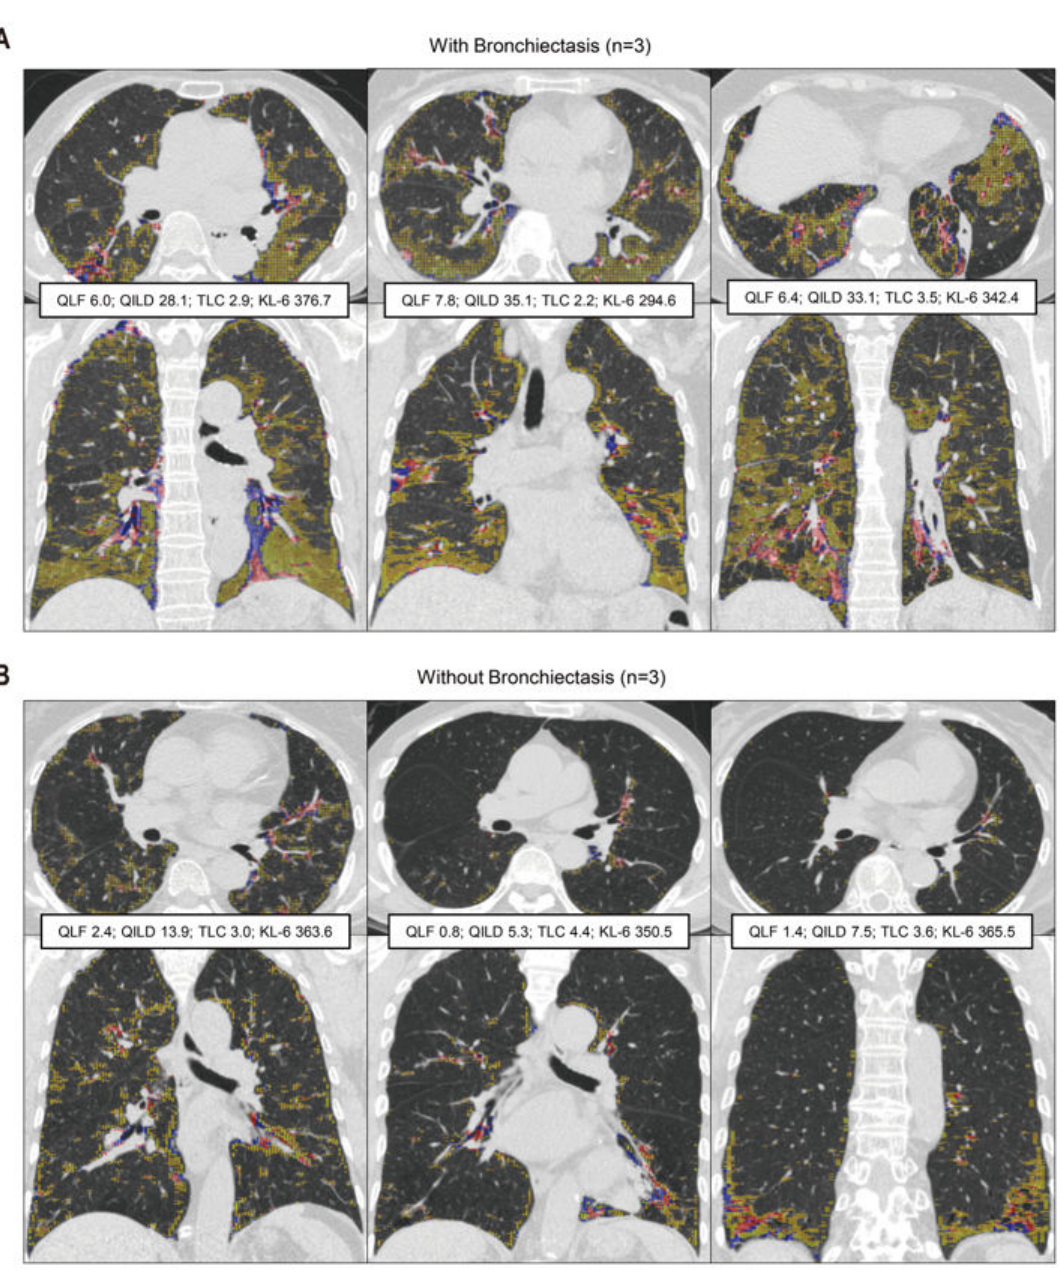
Figure 3. Two distinct patterns of association between QILD score and serum KL-6 level were presented by representative cases having similar serum KL-6 levels (cohort 2). ( A ) HRCT scans of 3 cases with bronchiectasis; QLF 6.7 ± 0.9, QILD 32.1 ± 3.6, TLC 2.9 ± 0.5 L, and KL-6 337.9 ± 41.2 U/mL. ( B ) HRCT scans of 3 cases without bronchiectasis; QLF 1.5 ± 0.8, QILD 8.9 ± 4.5, TLC 3.6 ± 0.6 L, and KL-6 359.9 ± 8.2 U/mL. Mean ± standard deviation; Upper row: transverse view; Lower row: coronal view; QLF = sum of red and blue dot, QGG = yellow